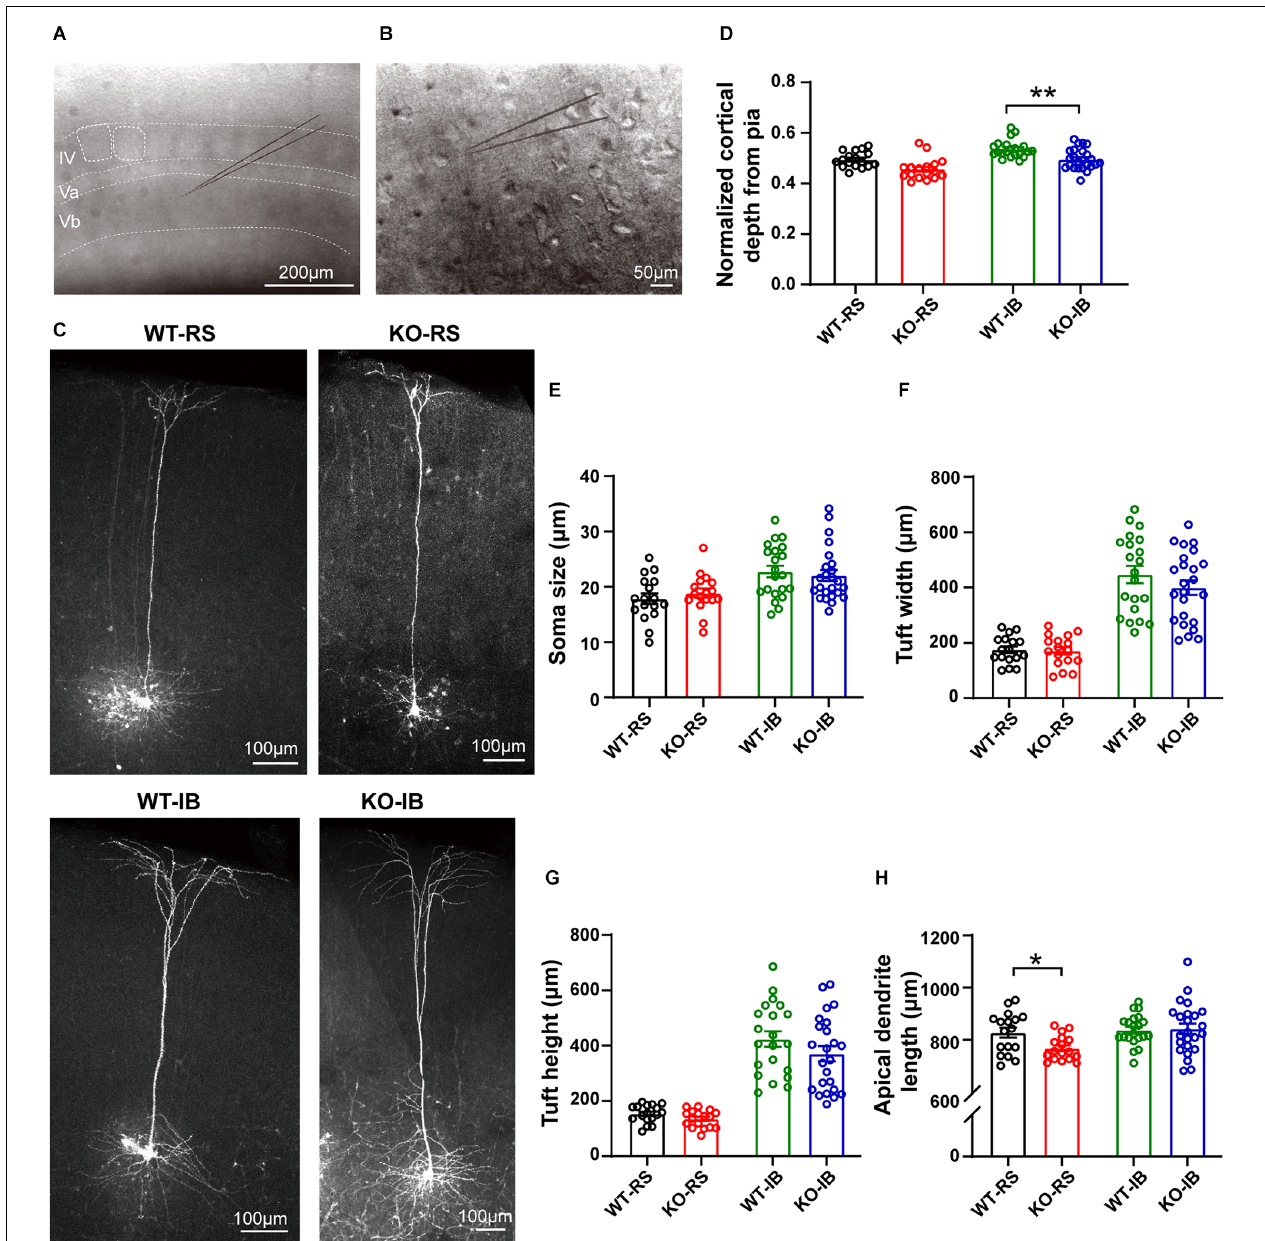
FIGURE 4 | Dendritic morphology of neurobiotin-labeled L5 pyramidal neurons. (A) Representative image of a coronal brain section containing the barrel cortex. Note the individual barrels, either outlined and not, in layer IV. (B) Individual pyramidal neurons in L5 in the mouse barrel cortex were recorded using whole-cell patch-clamp technique and filled with neurobiotin. (C) Representative neurobiotin-labeled recorded regular spiking (RS) and intrinsically burst spiking (IB) cells from WT and KO mice. (D) Quantification of normalized cortical depth from pia (WT-RS vs. KO-RS, t (32) = 1.662, p = 0.1063; WT-IB vs. KO-IB, t (43) = 2.975, p = 0.0048; unpaired t -test). (E) Quantification of soma size (WT-RS vs. KO-RS, t (32) = 0.7989, p = 0.4303; WT-IB vs. KO-IB, t (43) = 0.4851, p = 0.63; unpaired t -test). (F) Quantification of tuft width (WT-RS vs. KO-RS, t (32) = 1.712, p = 0.0966; WT-IB vs. KO-IB, t (43) = 1.348, p = 0.1847; unpaired t -test). (G) Quantification of tuft height (WT-RS vs. KO-RS cells, t (32) = 0.2174, p = 0.8293; WT-IB vs. KO-IB, t (43) = 1.185, p = 0.2425; unpaired t -test). (H) Quantification of length of primary apical dendrite (WT-RS vs. KO-RS, t (32) = 2.683, p = 0.0114; WT-IB vs. KO-IB, t (43) = 0.1928, p = 0.848; unpaired t -test). Number of mice and neurons used in (D–H) : RS (WT, n = 17; KO, n = 17) and IB (WT, n = 21; KO, n = 24) cells from WT ( N = 10 mice) and KO mice ( N = 13 mice). * p < 0.05; ** p <